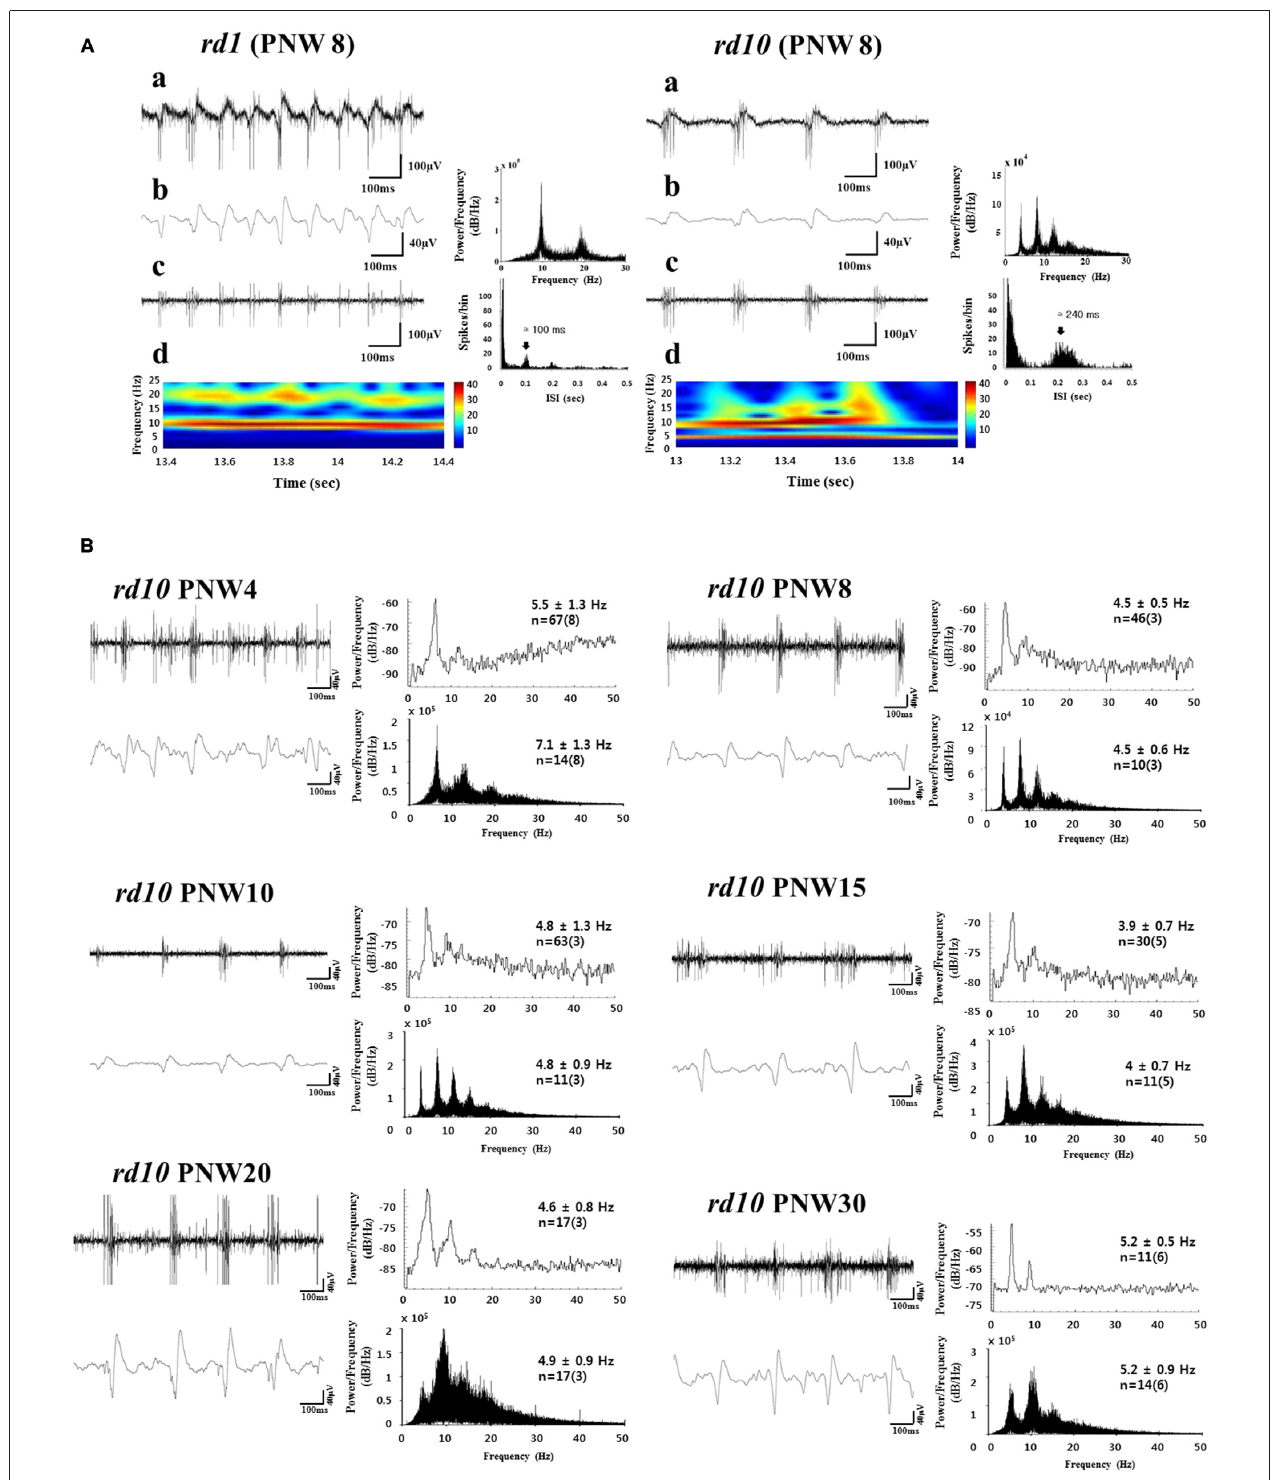
FIGURE 1 | Spontaneous rhythmic local field potential (LFP) and bursting retinal ganglion cell (RGC) spikes in rd retina. (A) Oscillatory rhythms in retinal degeneration ( rd ) mice models postnatal week (PNW) 8 ( rd1 , left panel; rd10 , right panel). A typical unfiltered recording of neural activity (a) , LFP waveform obtained from low-pass filtering with 20 Hz cutoff frequency and its power spectral density (PSD) estimated by the fast fourier transformation (FFT) (b) , and spiking activity obtained by high-pass filtering with 100 Hz cutoff frequency (c) shows a temporal structure of rhythmic bursts of spikes, where the inter-burst interval of ∼ 100